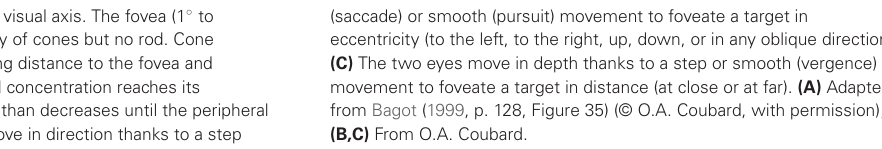
FIGURE 1 | (A) The human eye and its visual axis. The fovea (1 ◦ to 2 ◦ of visual angle) contains high density of cones but no rod. Cone concentration decreases with increasing distance to the fovea and stabilizes for the rest of the retina. Rod concentration reaches its maximum at 20 ◦ of retinal eccentricity than decreases until the peripheral limit of the retina. (B) The two eyes move in direction thanks to a step